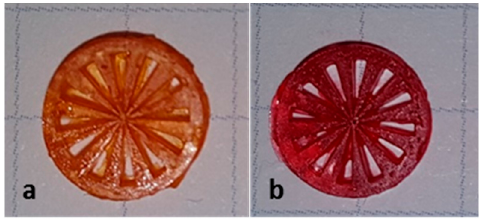
Figure 19. Green bodies of Siemens stars produced by LCM, using Disperse Orange 3 ( a ) and Su-